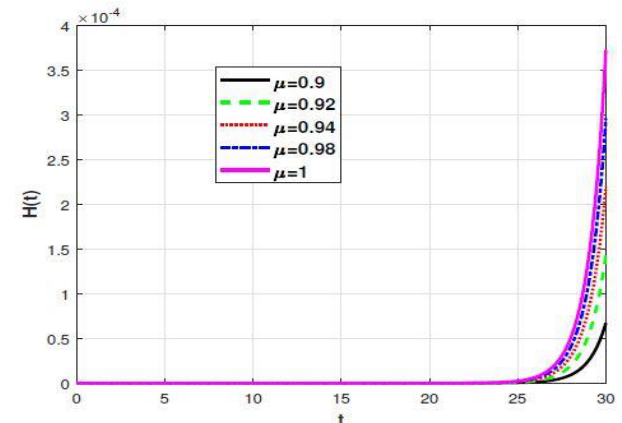
Fig. 7. Numerical experiments of acutely symptomatic infected detected class for various value of fractional order 𝝁 .